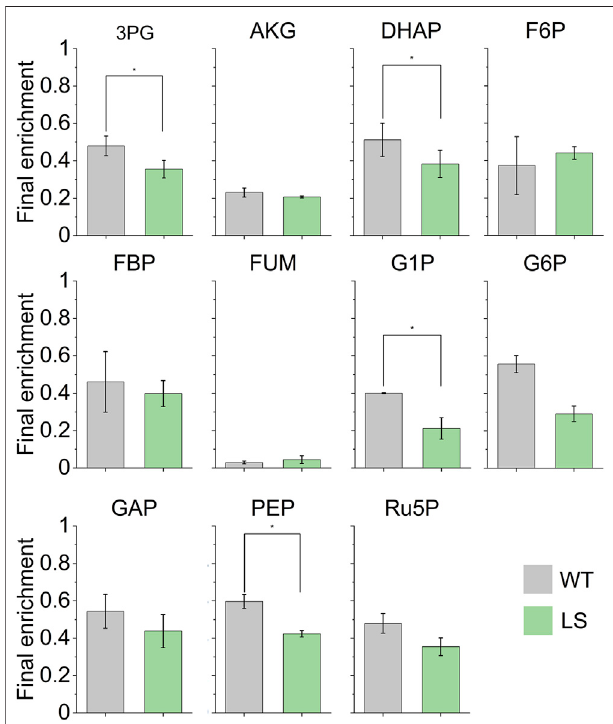
FIGURE 1 | Final 13 C enrichment of the 11 metabolites used to inform the fl ux distributions through the Synechococcus 7002 central metabolic network. Final enrichment values correspond to MID data at the 60 min timepoint ( Supplementary Figure S1 ). Error bars represent standard error ( n =3). Apaired two-tail Student ’ s t -test wasperformed and metabolites with a statistically signi fi cant difference ( p < 0.05) are indicated with p ( Supplementary Table S5